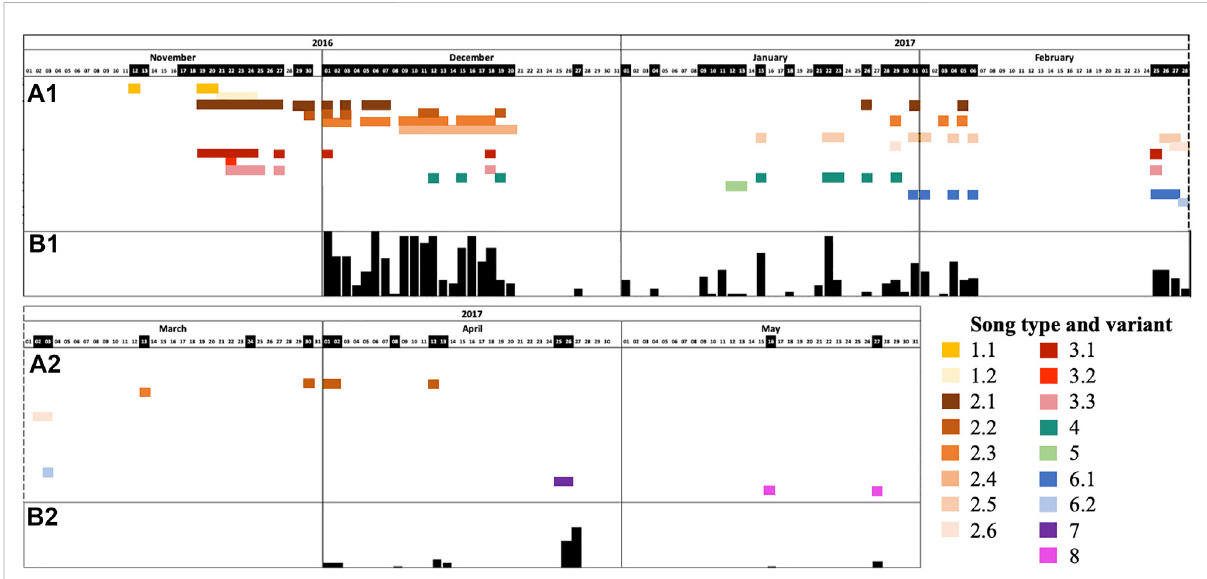
FIGURE 5 Temporal patterns in the occurrence of bowhead whale song types in eastern Fram Strait (79 ° 00.02 ′ N, 5 ° 40.12 ′ E) between November 2016 andMay2017. Calendar days onwhich distinct song types ofbowhead whales wererecorded ineasternFram StraitbyE-2016from November 2016 until February 2017 (A1) and March until May 2017 (A2) . Black bars indicate the number of hours per day [h d − 1 ] with acoustic presence of bowhead whales from November 2016 until February 2017 (B1) and March until May 2017 (B2) . Variants of the song types are assigned a sub-